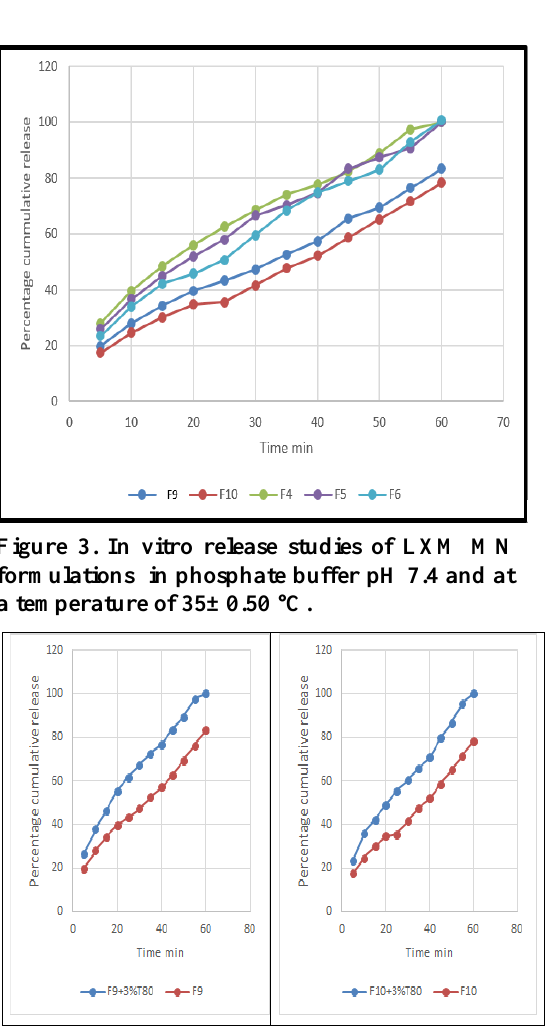
Figure 4. In vitro release studies of F10 and F9 with and without 3 % Tween 80 in phosphate buffer pH 7.4 and at a temperature of 35± 0.50 °C